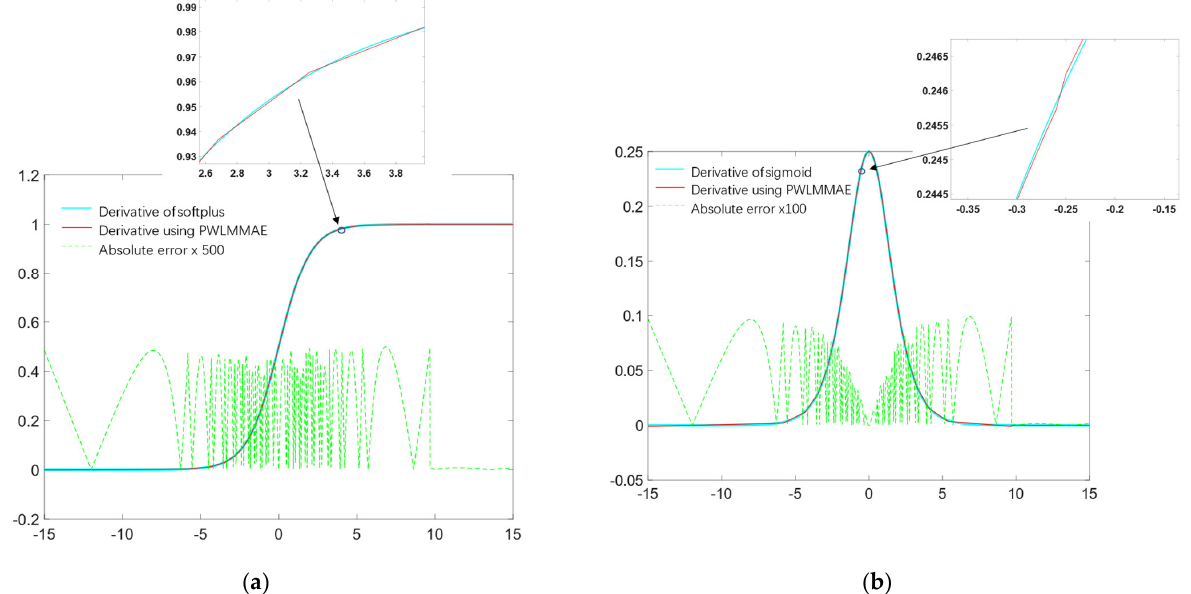
Figure 3. ( a ) approximation of derivative of softplus. ( b ) approximation of derivative of sigmoid.